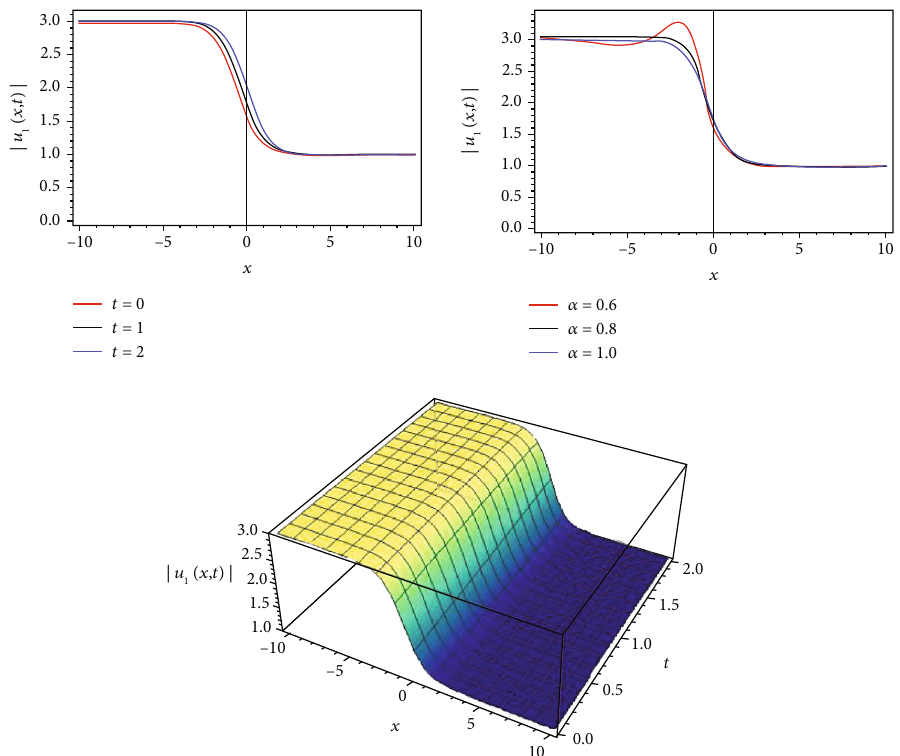
Figure 5: 2D and 3D graphics of Case 1 for hyperbolic traveling wave solution (38) at f α = 0 : 6, k = 1 : 5, q = 1, s = 1, c = 0 : 5, λ = 1 g :